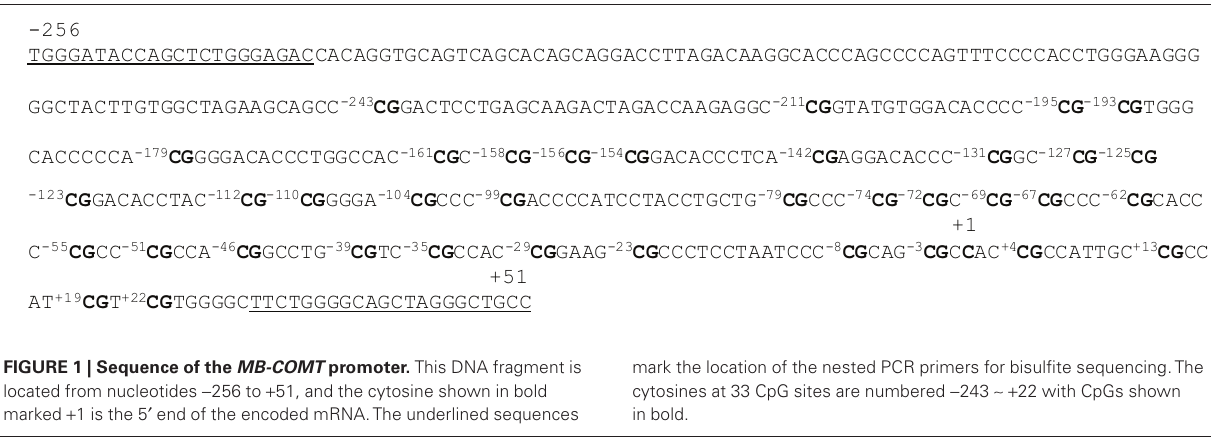
mark the location of the nested PCR primers for bisulfite sequencing. The cytosines at 33 CpG sites are numbered − 243 ∼ + 22 with CpGs shown in